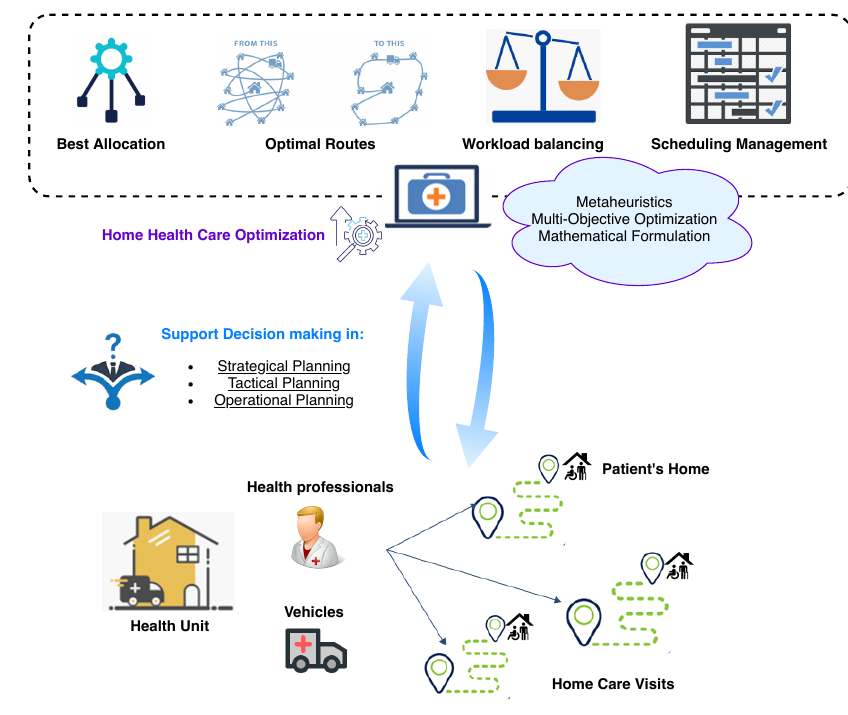
Figure 2. Architecture to support decision-making in